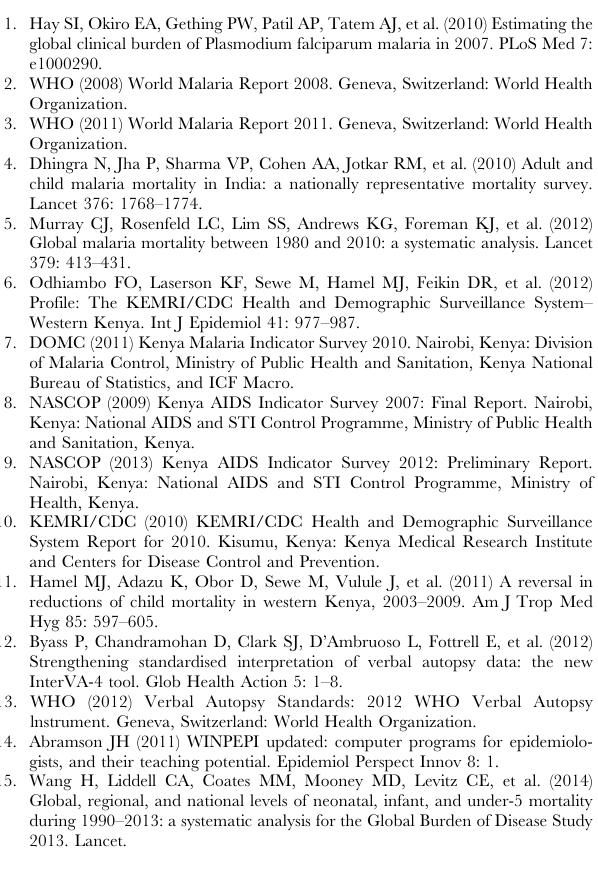
Table S1 Proportion of malaria deaths out of those with acute fever, by age and